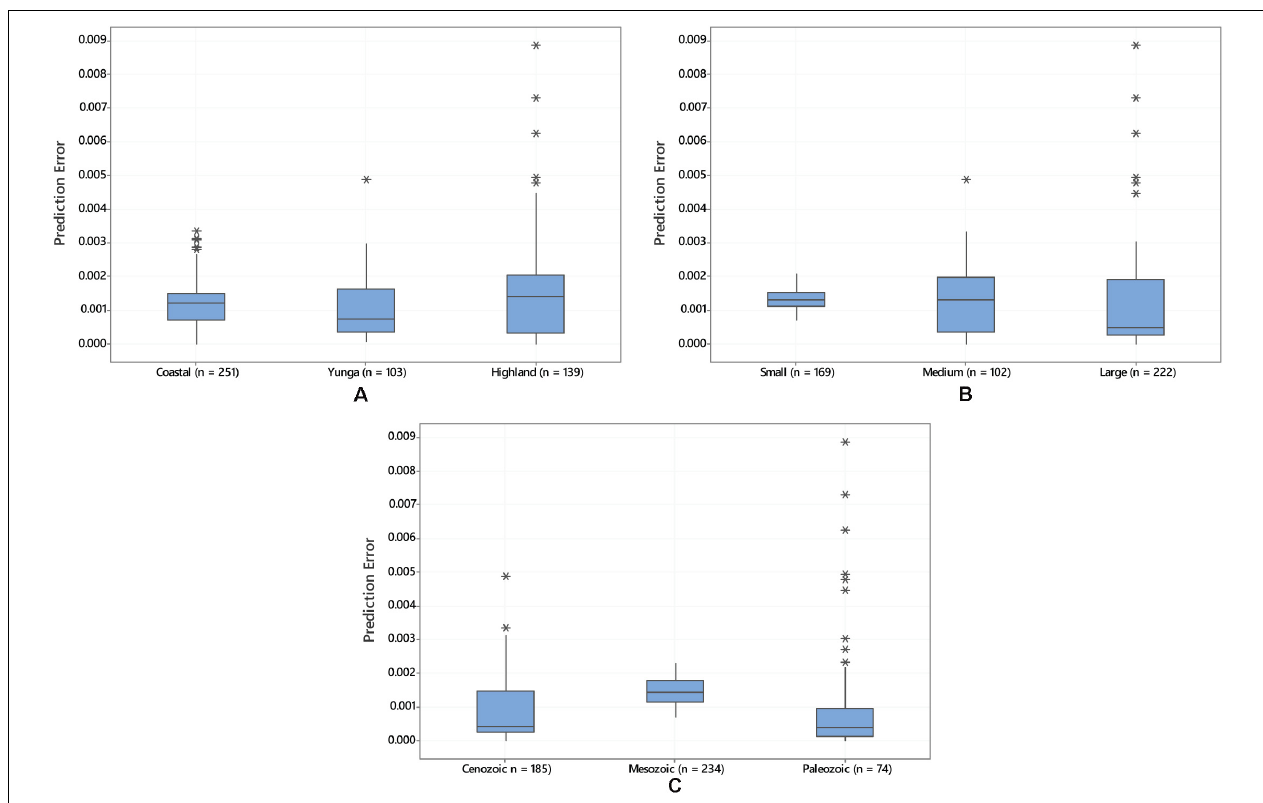
FIGURE 6 | (A) Boxplot of predicted-measured error in 87 Sr/ 86 Sr for archeological samples from coastal, yunga , and highland elevations; (B) Boxplot of predicted-measured error in 87 Sr/ 86 Sr for archeological samples from small, medium, and large watersheds (in hectares); and (C) predicted-measured error in 87 Sr/ 86 Sr for archeological samples overlying geological units dating to the Cenozoic, Mesozoic, and Paleozoic eras (from most recently to oldest deposited bedrock). The predicted-measured errors plotted are from 493 published archeological samples trimmed of IQR